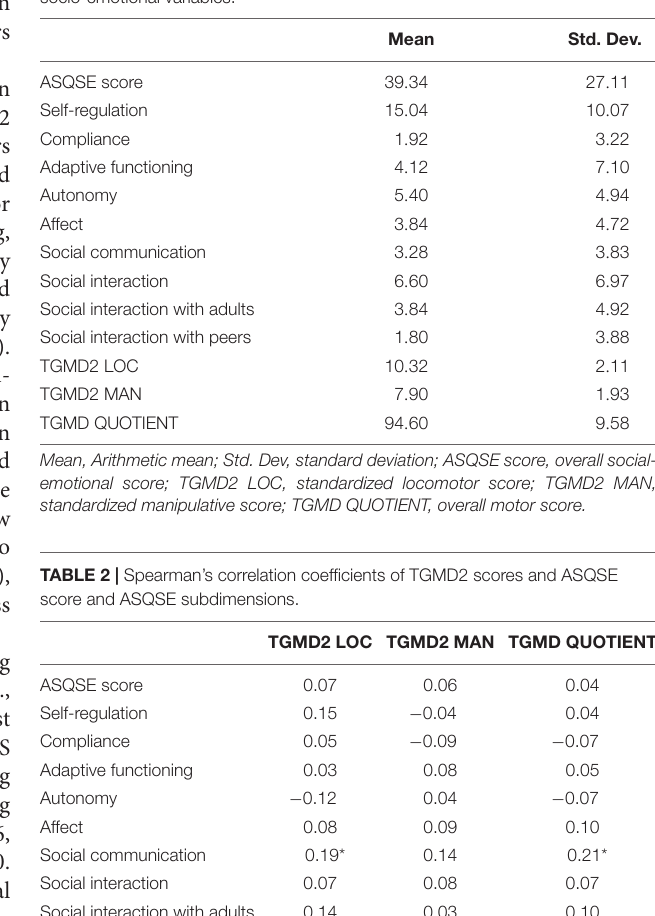
TABLE 1 | Mean values and standard deviation of motor competence and socio-emotional variables.